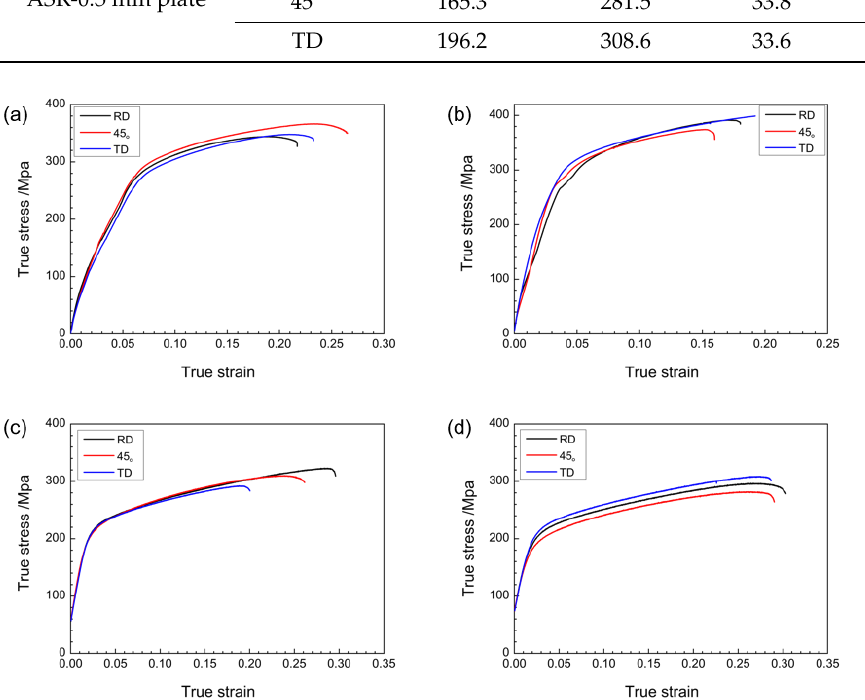
Figure 9. Tensile curves at room temperature along RD, 45°, and TD directions of sampled plates: ( a ) SR-3.4 mm plate, ( b ) ASR-1.5 mm plate, ( c ) ASR-0.75 mm plate, and ( d ) ASR-0.5 mm plate. Table 3. Mechanical properties of plates sampled in different passes.